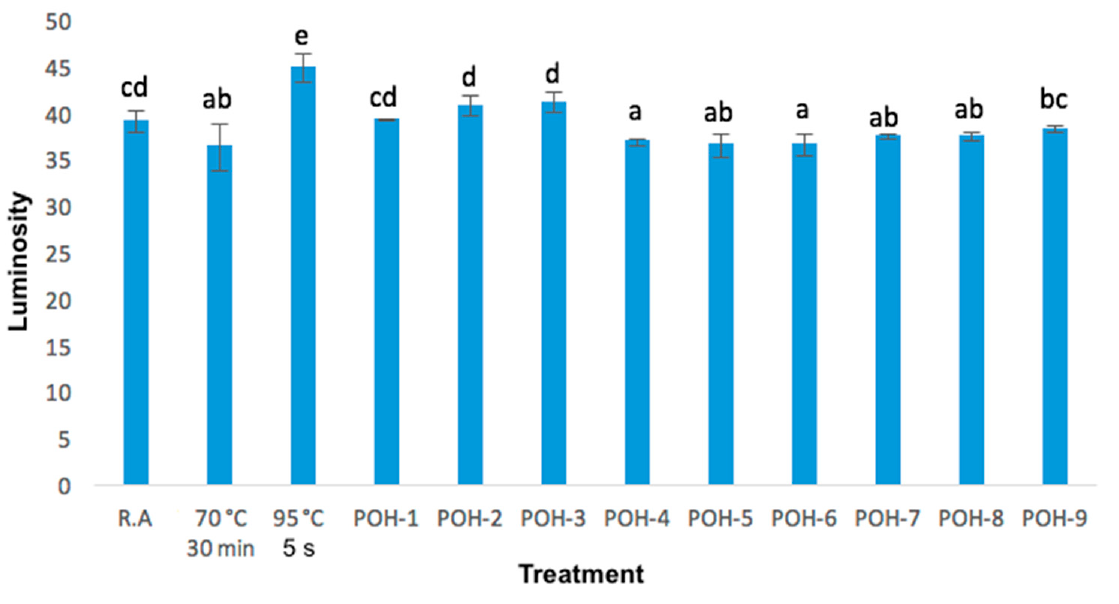
Figure 4. Luminosity changes in raw aguamiel, pasteurized aguamiel (70 °C, 30 min), pasteurized aguamiel (95 °C, 5 s) and ohmic heating treatments ; data is mean (±standard deviation) of three replicates. a, b, c, d, e different letters indicate significant differences ( p < 0.05).